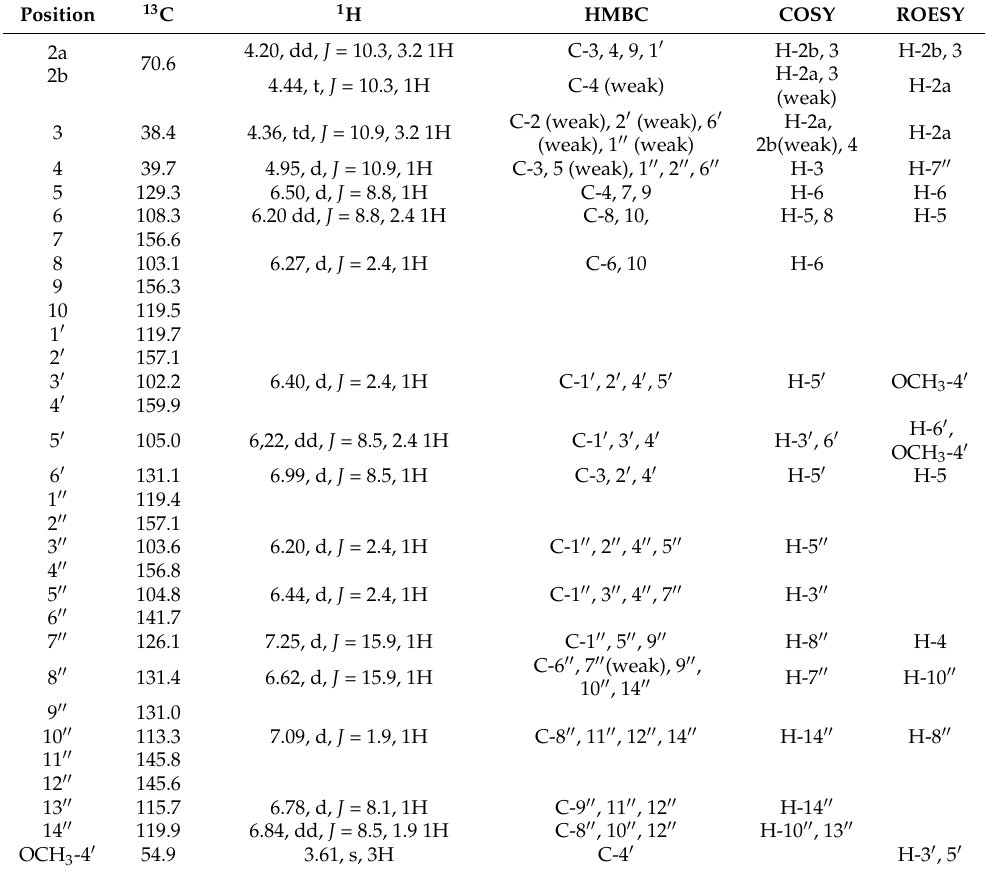
Table 2. 1 H (700 MHz), 13 C (175 MHz), HMBC, COSY, and ROESY NMR data for compound 1b ( δ in ppm, J in Hz, acetone- d 6